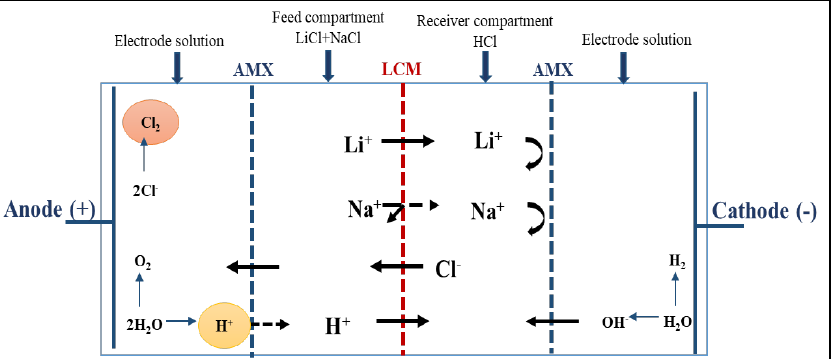
Figure 3. Schematic illustration and operating principle of our four-compartment ED cell. Adapted from [77].